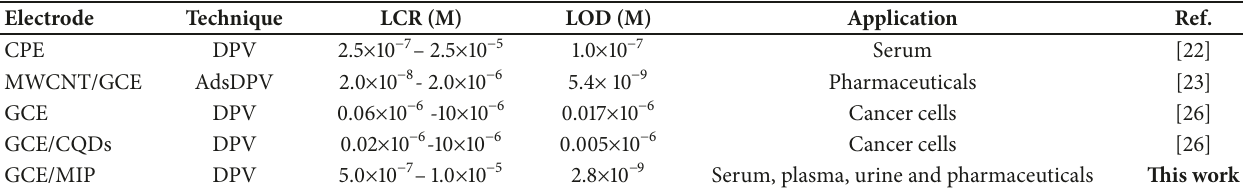
Table 5: Comparison of the present work and previous electrochemical studies for the determination of